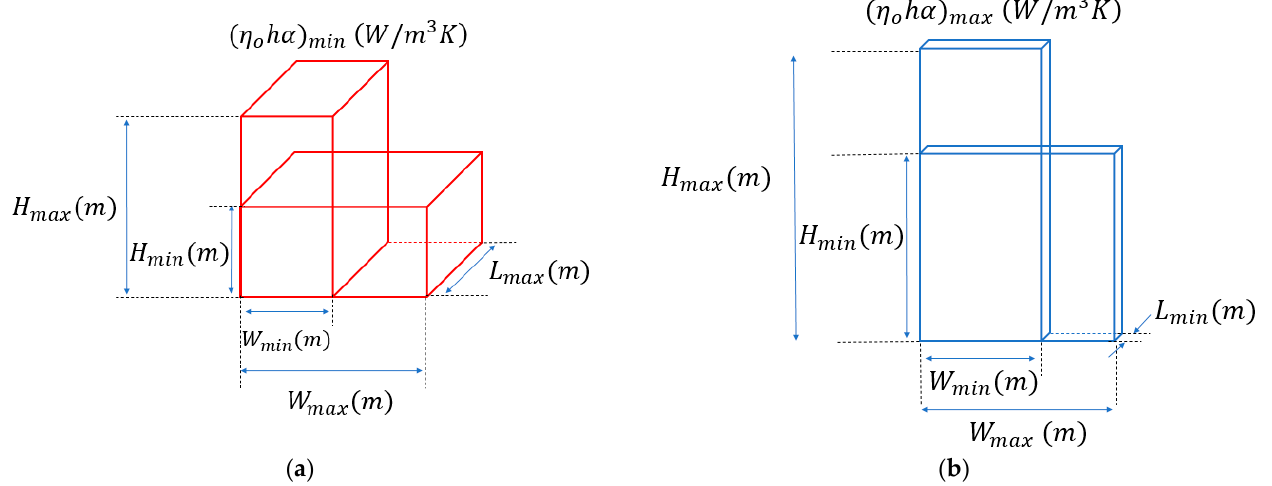
Figure 4. Pictorial representation of the volume design region: ( a ) maximum volume, ( b ) minimum volume.